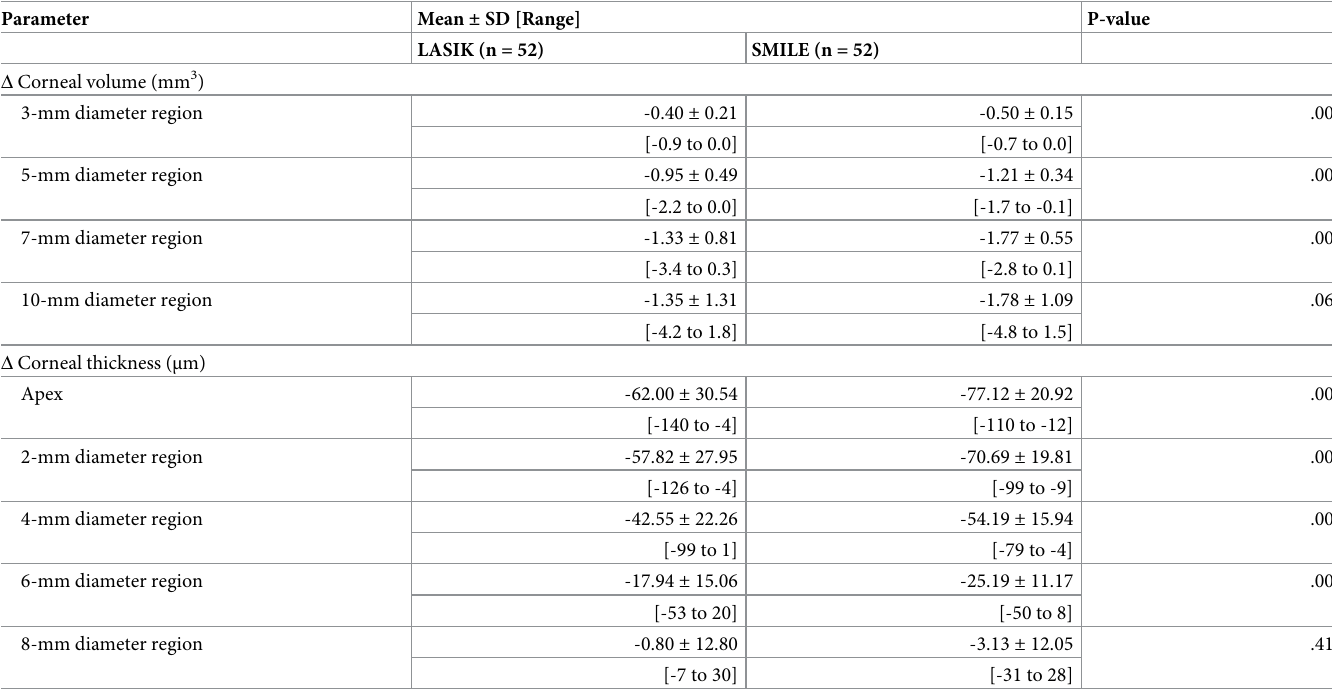
Table 2. Differences of 3-month postoperative minus preoperative measurements.